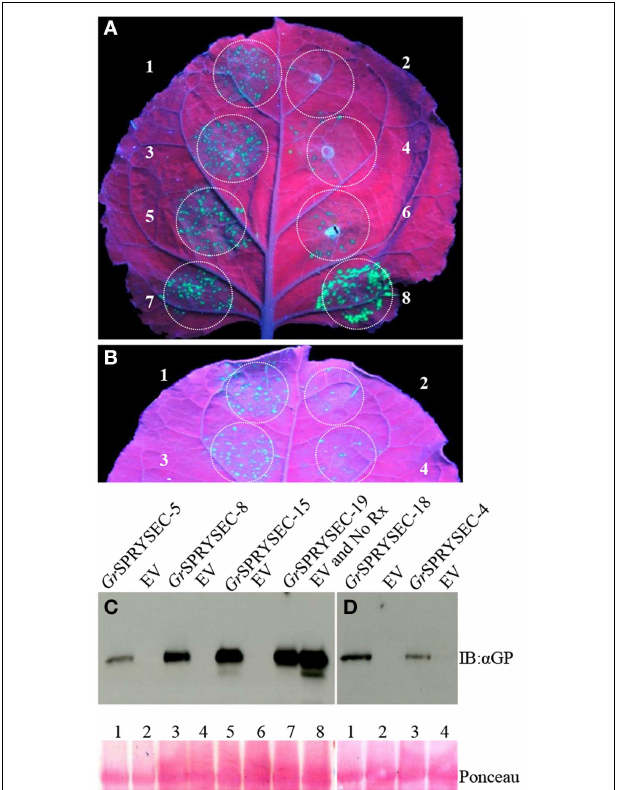
FIGURE 3 | Gr SPRYSECs suppress Rx-mediated resistance to PVX. N. benthamiana leaves were co-infiltrated with Agrobacterium carrying binary vectors expressing PVX-GFP and Rx together with (A) 1, Gr SPRYSEC-5; 2, empty vector; 3, Gr SPRYSEC-8; 4, empty vector; 5 Gr SPRYSEC-15; 6, empty vector; 7, Gr SPRYSEC-19; 8, empty vector; and Rx replaced with empty vector. (B) 1, Gr SPRYSEC-18; 2, empty vector; 3, Gr SPRYSEC-4; 4, empty vector; GFP expression was visualized and photographed under UV illumination at 4 DPI. (C,D) Anti GFP immune blotting was performed on total protein samples taken at 4 DPI from infiltrated N. benthamiana leaf patches expressing the different construct combinations as described in (A,B) . Numbering corresponds to the number on the leaf above each blot. Ponceau staining (lower panel) was used to show equal